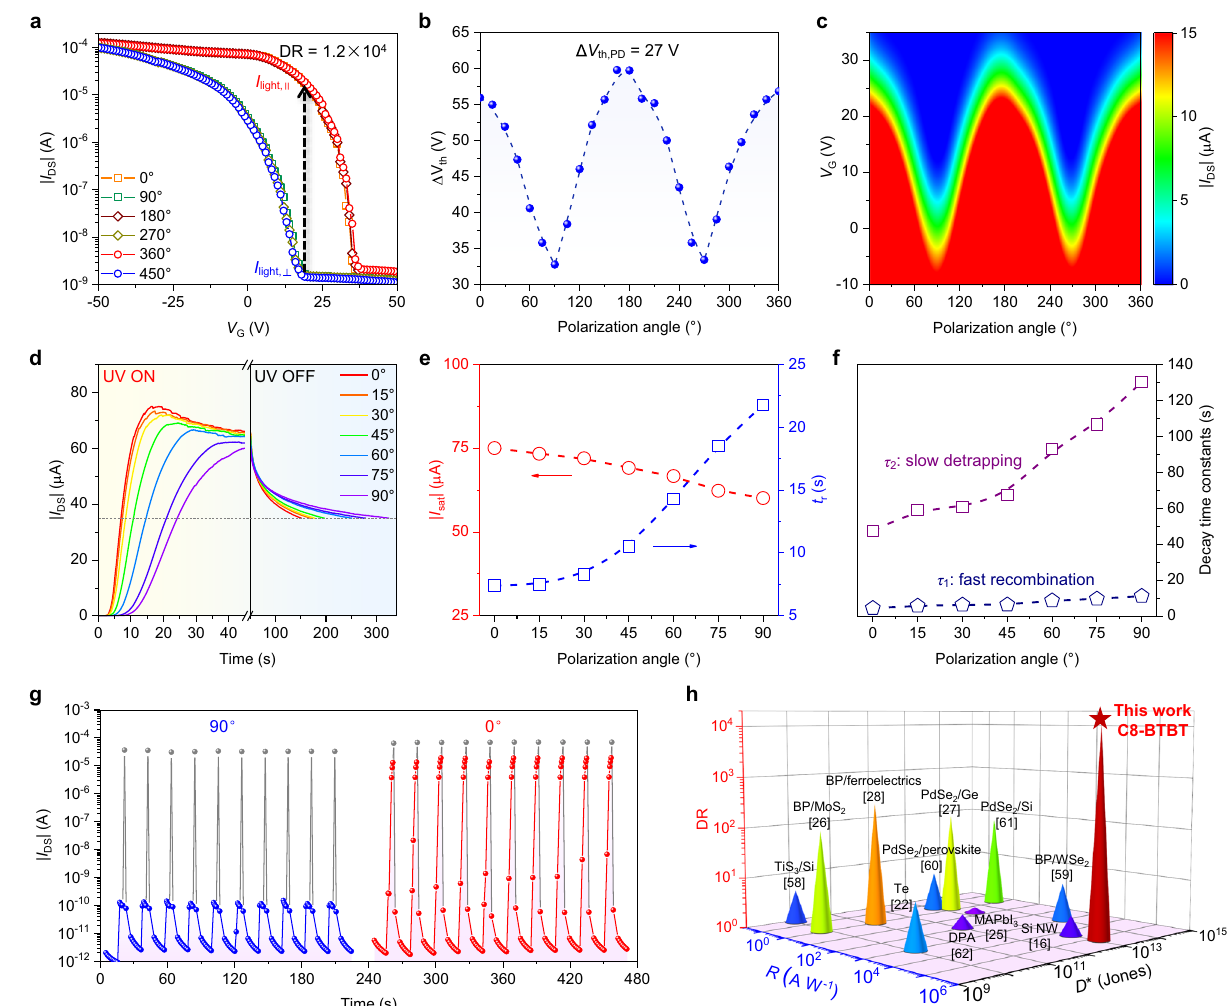
Fig. 3 | Polarization-sensitive photodetection of the C8-BTBT crystal array. a Polarization-dependent transfer curves of the OPT under the illumination of 365nmpolarizedlightwitha fi xedintensityof110 μ Wcm − 2 ( V DS = − 40V). b Periodic variation of Δ V th with the change of polarization angles. c Smoothed contour plot of polarization-dependent I DS versus V G ( V DS = − 40V). d Time-related evolution of I DS uponturningon/offthepolarizedlight( V G =25V, V DS = − 40V). e Dependenceof I sat and t r onpolarizationangle. t r isde fi nedasthetimerequiredfor I light toincrease